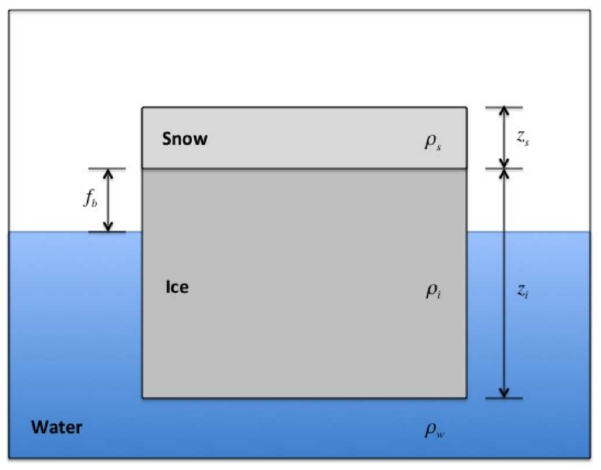
Figure 3. Illustration of the parameters involved in sea ice thickness computation using sea ice